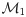
Comparison of the MSE obtained by the three models, M1, M2, and M3, averaged over the 40 countries.A smaller value for the MSE indicates a better predictive performance.